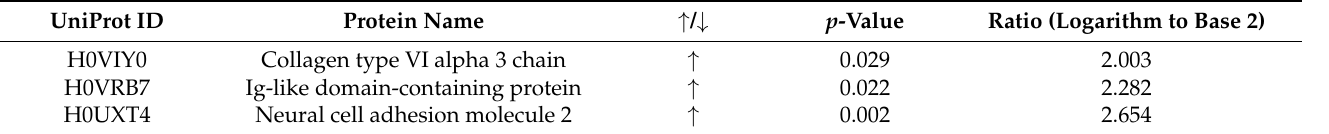
Table 1. Significant ( p < 0.05) altered proteins in the ears implanted with IGF-1 in comparison to the ones implanted with AP. They are all increased ( ↑ ) in the IGF-1 treatment group.